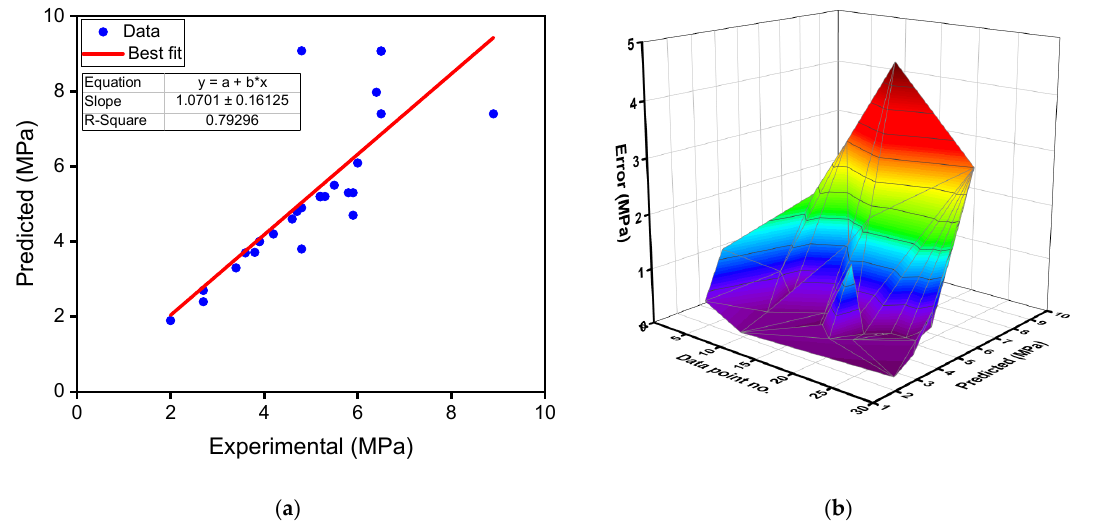
Figure 7. Gradient boosting model for flexural strength: ( a ) relationship between experimental and predicted results; ( b ) spreading of predicted and error values.